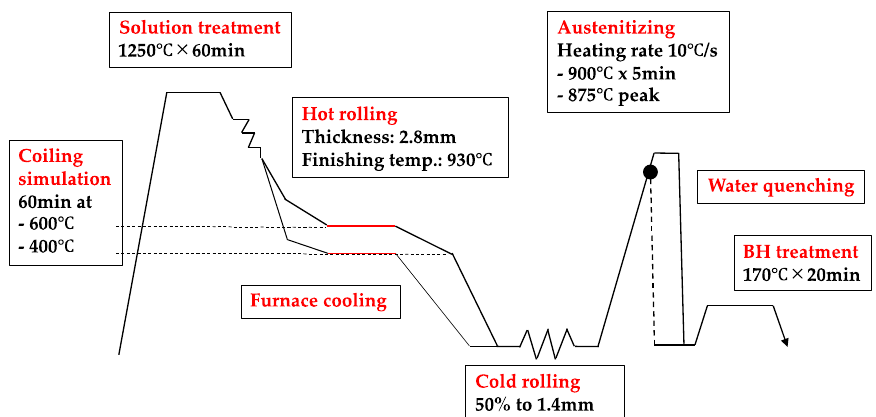
Figure 2. Thermo-mechanical treatment schedule for sample production of press hardening steel.